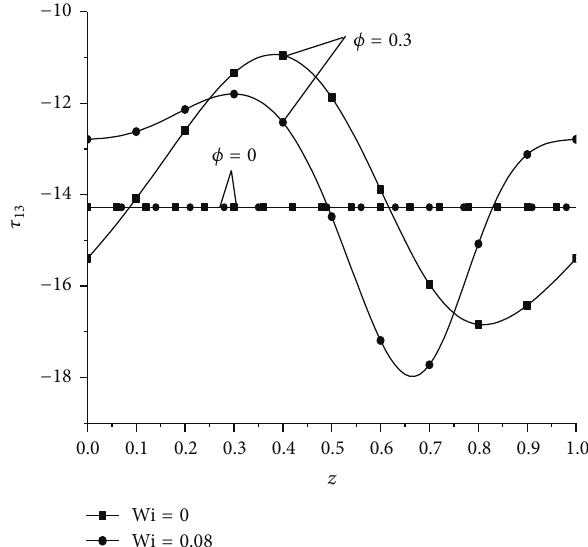
Figure 16: Wall shear stress 𝜏 13 at the inner wall versus 𝑧 with different values of 𝜙 and Wi at 𝜖 = 0.1 , 𝑄 = 1 , 𝛿 = 0.08 , and Re = 10